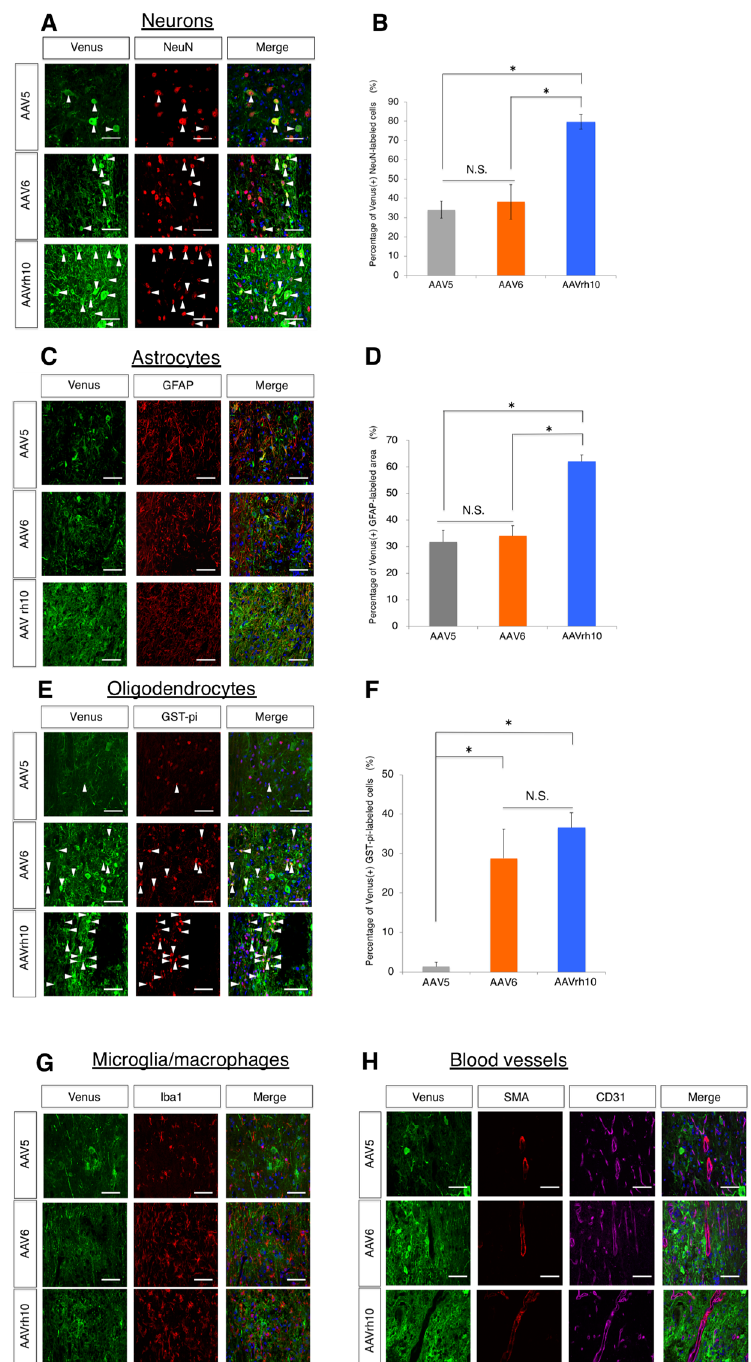
Figure 4. Cellular tropism of AAV5, 6, and rh10 in the injured spinal cord during the chronic phase. Sections were immunostained with an anti-GFP antibody, together with cell type-specific markers for neurons (NeuN) ( A ), astrocytes (GFAP) ( C ), oligodendrocytes (GST-pi) ( E ), microglia/microphages (Iba1) ( G ) or blood vessels (CD31 and SMA) ( H ) at 6 weeks after AAV injection. Scale bars, 50 μ m. Quantification of the transduction rates in neurons, astrocytes and oligodendrocytes is shown in ( B ), ( D ) and ( F ), respectively. The green fluorescence of representative images was adjusted. Arrowheads indicate examples of double-positive cells. * p < 0.05 and not significant (N.S.) according to one-way ANOVA with the Tukey-Kramer test. Data are presented as the mean ± SEM. n = 4 for each